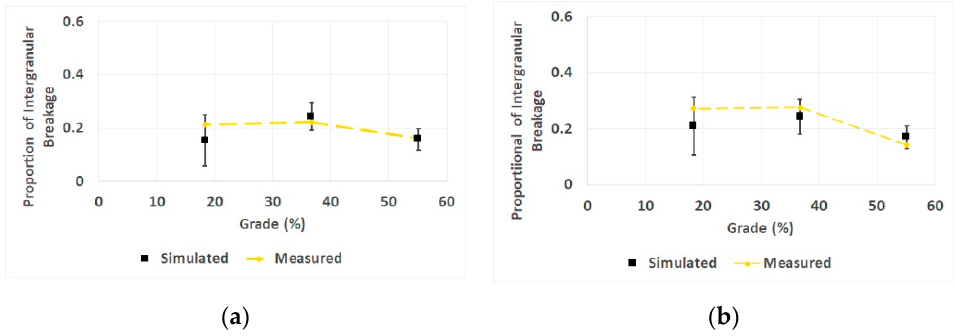
Figure 9. Dependency of contribution of intergranular breakage on the grade of the ore with cement grains; ( a ) energy level of 117.2 (kJ), ( b ) energy level of 102 (kJ).